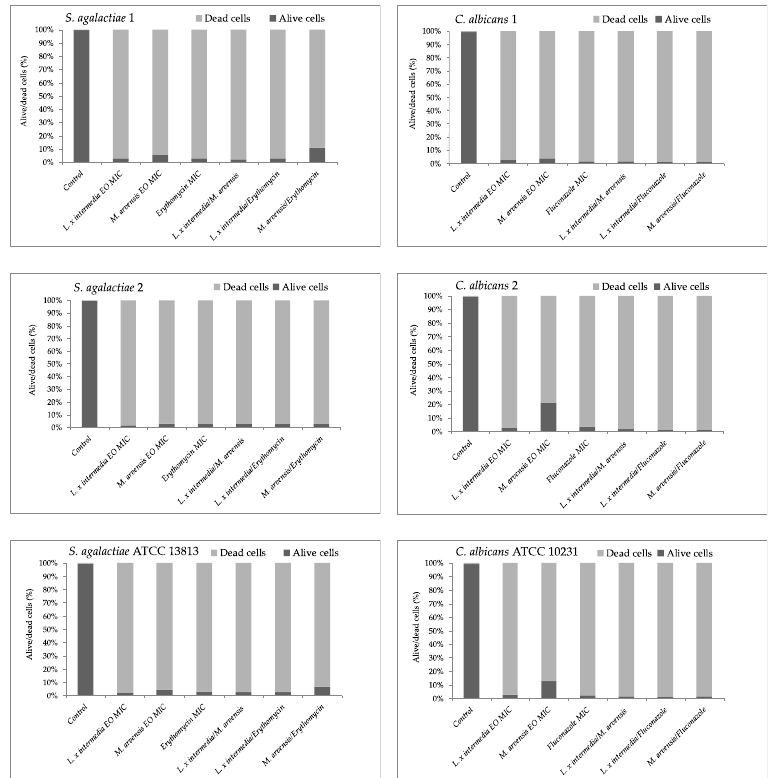
Figure 5. Quantification of alive / dead cells in the biofilm. Relative fluorescence units (RFU) mean of alive and dead cells into S. agalactiae and C. albicans biofilm, treated with L. x intermedia and M. arvensis EOs, antimicrobials (erythromycin and fluconazole), and with different combinations (antimicrobial/EO and EO/EO). The data shown are representative of three determinations. Statistically significant difference between alive and dead cells ( p -values < 0.05) was detected by Qui-square test.